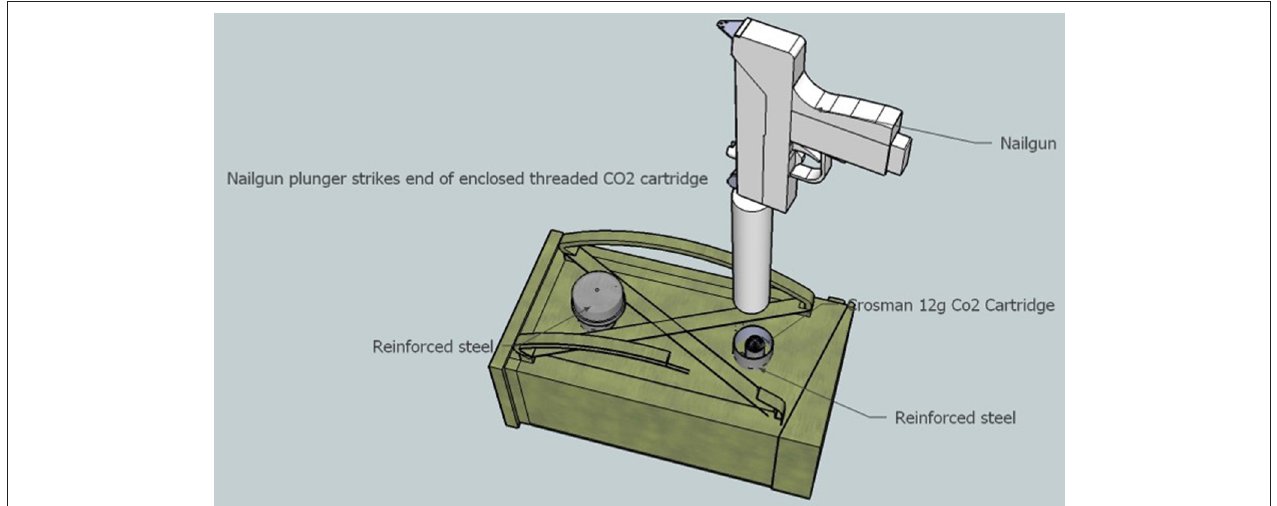
FIGURE 1 | Superior mock-up view of apparatus to discharge black power explosion into cartridge of human blood. A stainless-steel Crossman 12g CO 2 threaded cartridge which contains each sample of human blood was sealed with an nickel plated steel acorn nut was place within a reinforced steel pipe (blast chamber) and capped off to protect the operator from the explosive nail-gun force. The nail gun was positioned above the blast chamber. The chamber was then encompassed in a wooden encasement to position the two chambers in an upright parallel state.